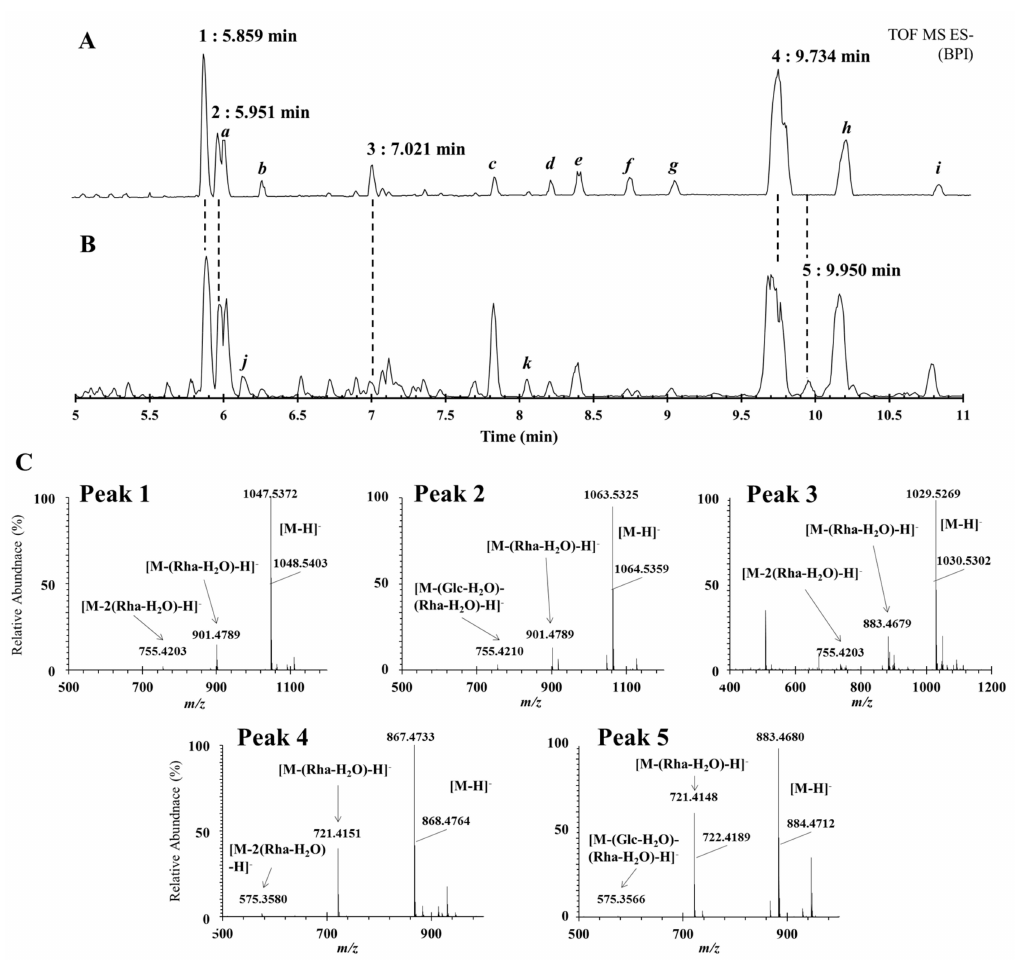
Figure 3. ( A ): Representative base peak intensity (BPI) chromatogram of DN and ( B ): DQ. ( C ): MS / MS spectrum of peak 1 (5.859 min), peak 2 (5.859 min), peak 3 (5.859 min), peak 4 (5.859 min), and peak 5 (5.859